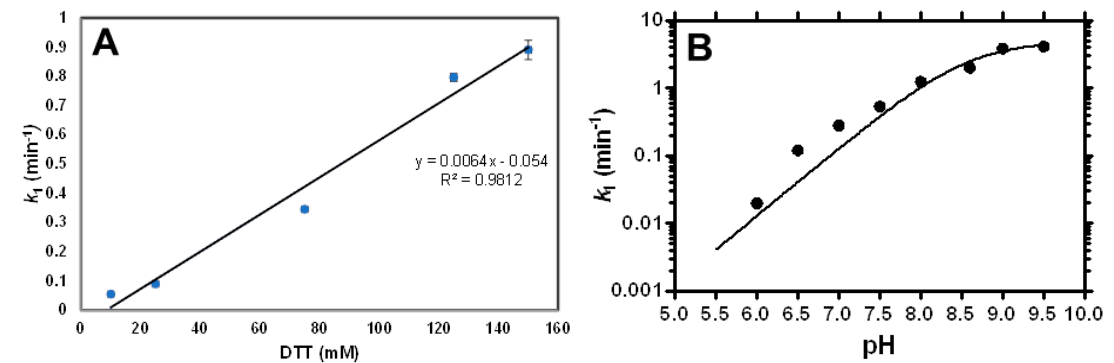
Figure 2. Titration studies to determine the reaction mechanism of 11 with DTT. ( A ) Kinetic analysis of [DTT] titration on the 11 -DTT reaction was performed in the presence of 25 μ M of 11 . ( B ) Kinetic analysis of pH titration on the 11 -DTT reaction was carried out in the presence of 25 μ M of 11 and 50 mM of DTT, while varying pH and/or buffers. Please see Materials and Methods for the details.